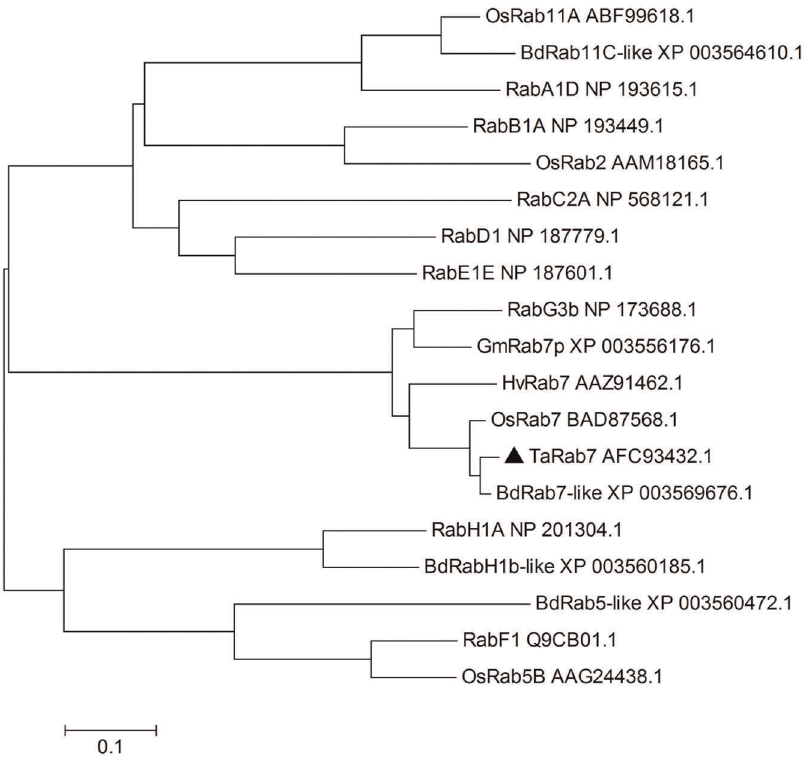
Figure 2. A representative phylogenetic tree of TaRab7 and selected Rab7 proteins. A representative phylogenetic tree of TaRab7 , Rab family member proteins in Arabidopsis , Oryza Sativa and Brachypodium distachyon , and Rab7 proteins from soybean ( GmRab7 ) and barley ( HvRab7 ). GeneBank accession numbers are provided after the gene names.